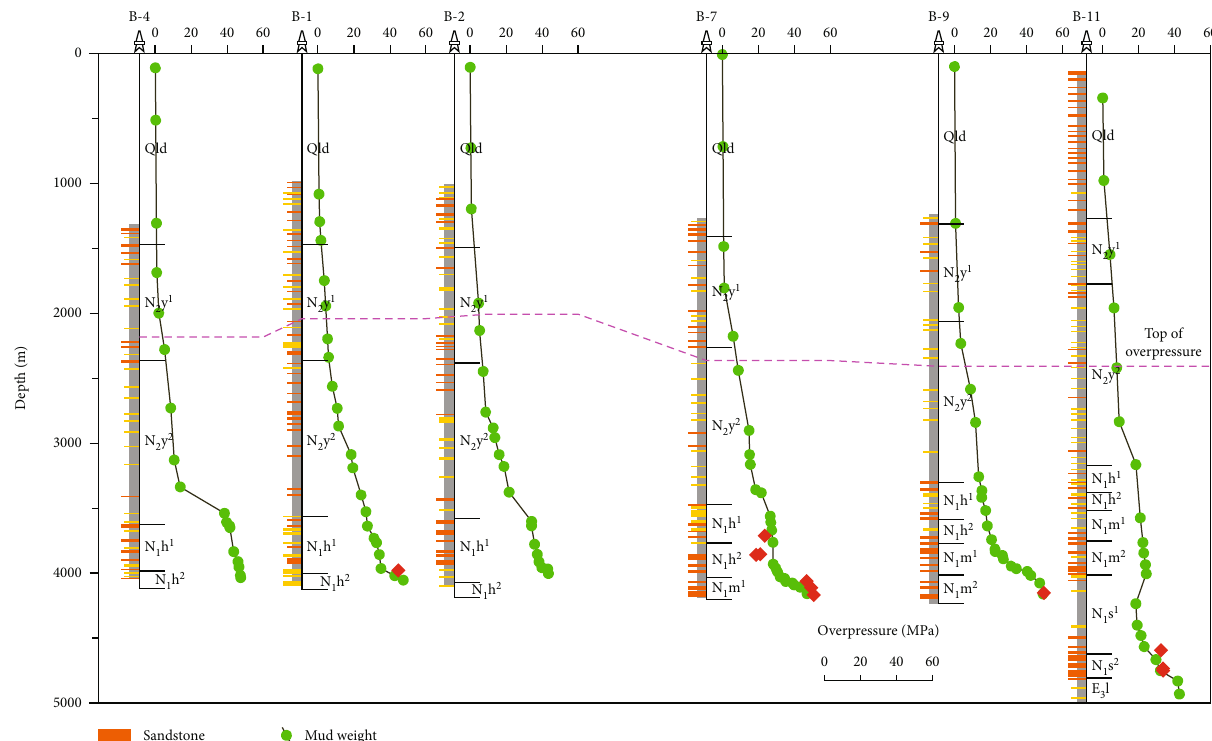
Figure 6: Pore pressure distributions in the LD-B Wellblock, showing the top of the overpressure. The pore pressure was obtained from the MDT, DST, and mud weight. The location of the section is shown in Figure